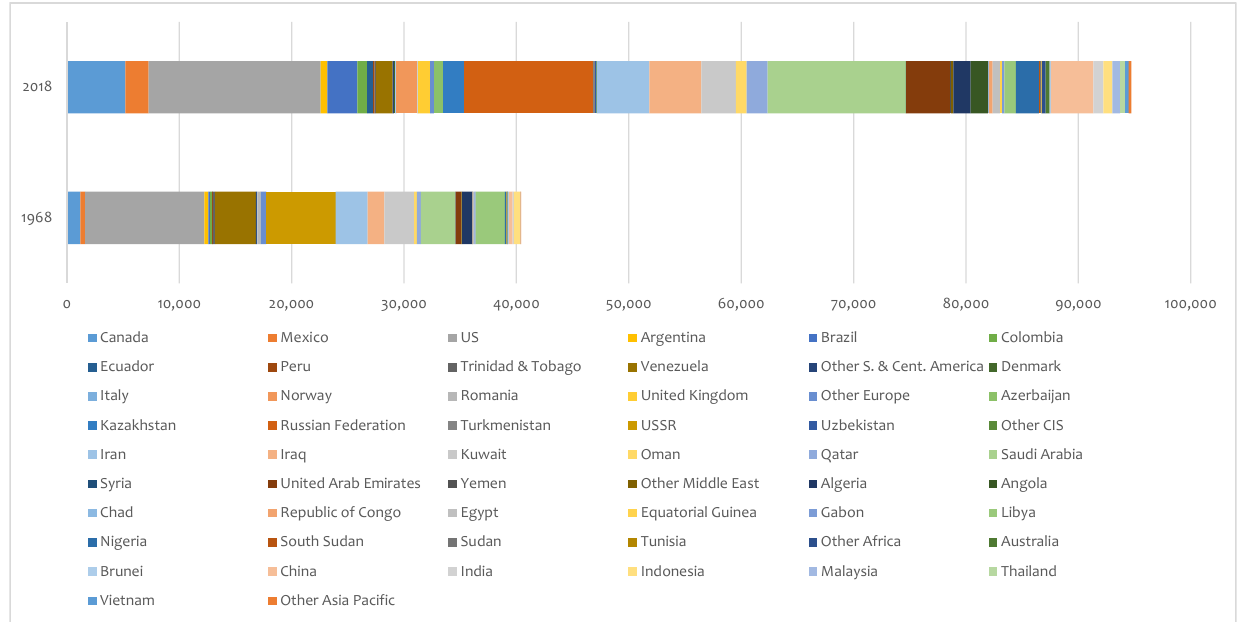
Figure 10. Diversification of global oil supply (data were collected from [22]).